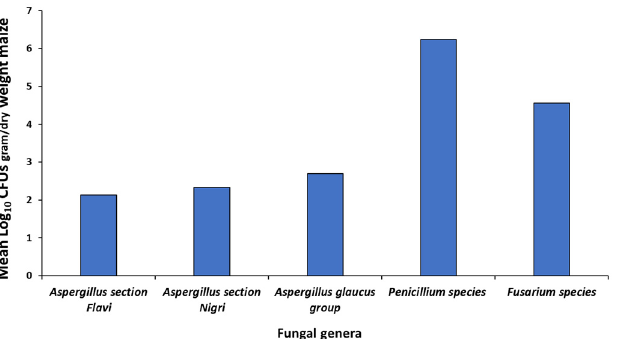
Figure 1. Mean fungal populations (Log 10 CFUs/g maize) isolated from the naturally contaminated maize using serial